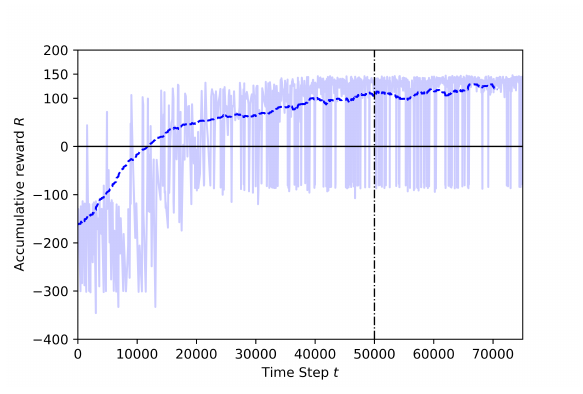
Figure 12. Training result for Case 1.1.